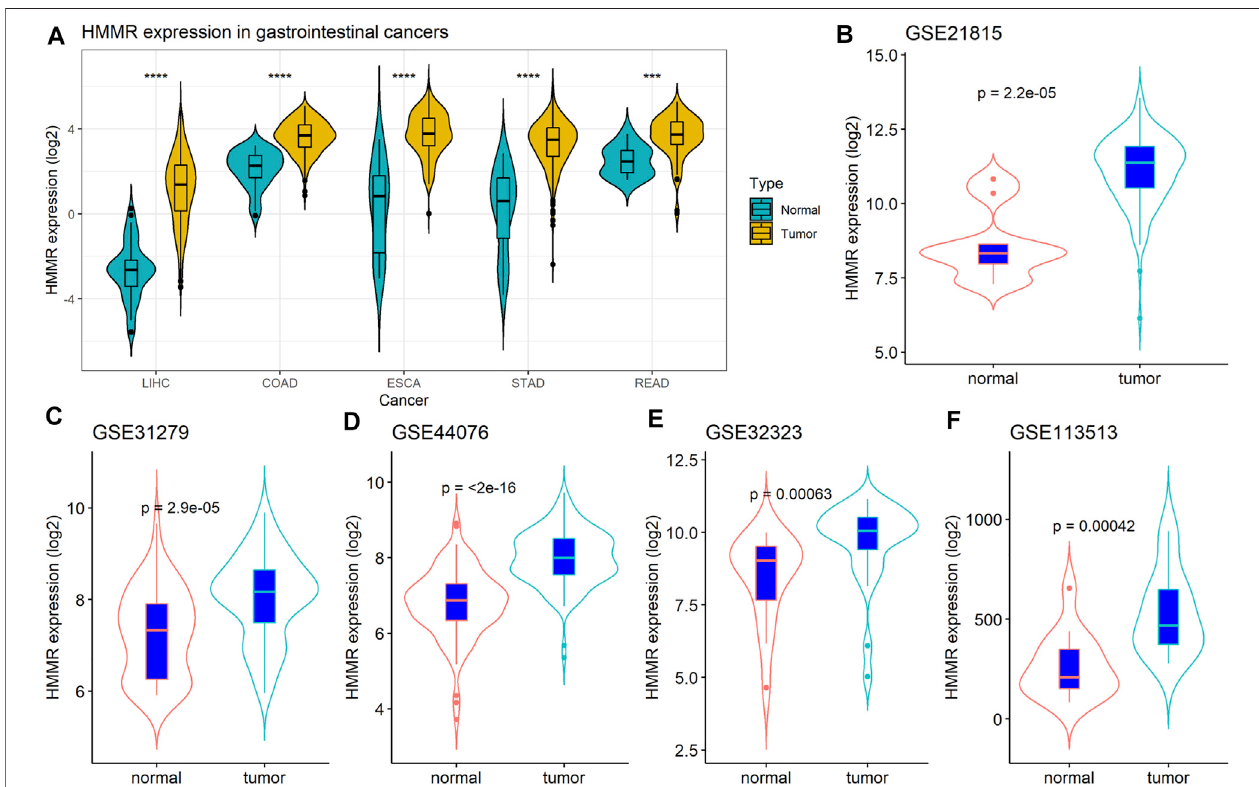
FIGURE1|(A) Expressionof HMMR incolorectalcancer(CRC)basedonTheCancerGenomeAtlas(TCGA)andGeneExpressionOmnibus(GEO)datasets. (B-F) Comparison of HMMR in CRC and normal tissues in fi ve GEO